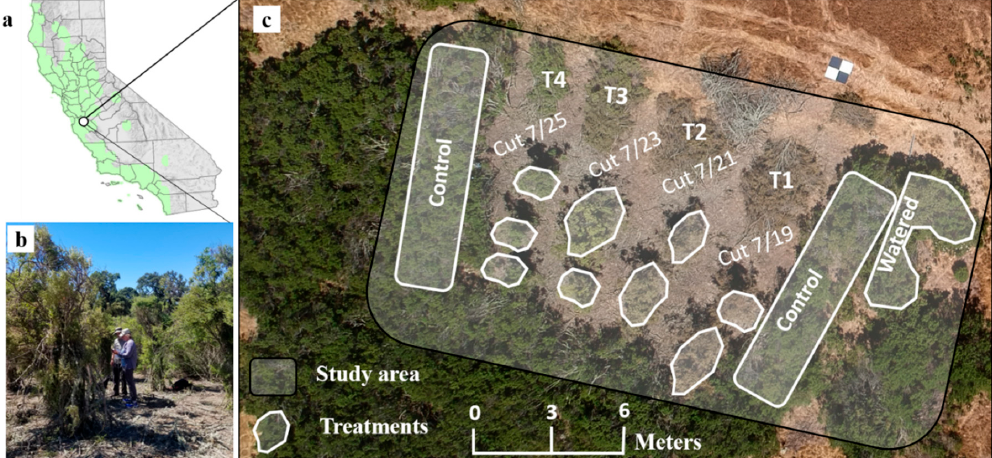
Figure 1. Experimental plot at Blue Oak Ranch Reserve (BORR): (a) study area location near San Jose, California, and range of B. pilularis ; (b) experimental site from the ground; (c) detailed aerial depiction of experiment.